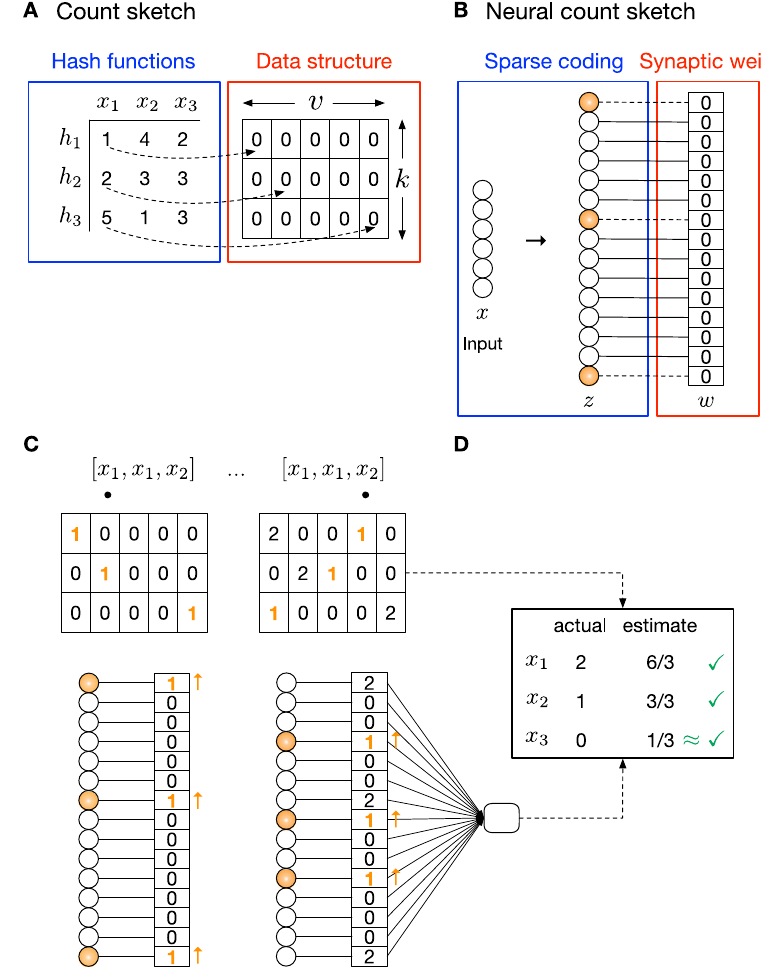
Fig. 1 | The count sketch and corresponding neural circuit implementation. A The count sketch data structure is a 2D matrix C of counters with k rows and v columns. There is one hash function h per row, each of which determines which column in the row is modi fi ed when an item x is observed (dotted arrows). B The neural implementation of a count sketchuses a 1D array w of k × v synapses. When an item is observed, the synapses of the k pre-synaptic neurons that are active for the item (orange highlight) are modi fi ed. The neurons activated for the item are determined using a hash function that assigns the item a sparse, high-dimensional representation ( z ). In this example, each item x is a d -dimensional vector. C To insert an item from the sequence into the count sketch (top), k counters are incremented. For example, after the fi rst time ( x 1 ) is observed, in the fi rst row, the